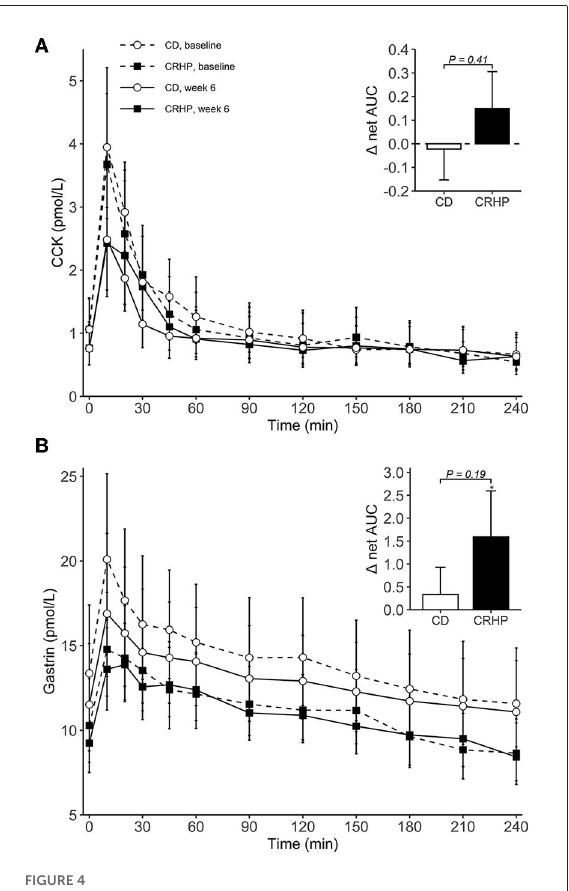
FIGURE4 Plasma concentrations of CCK (A) and gastrin (B) during an OGTT at baseline and after 6 weeks of a CD or CRHP diet. Inserted plots represent net AUC in the units stated x 240min. Data are presented as mean ( SEM) following ± log-transformation, except for net AUCs; * P <